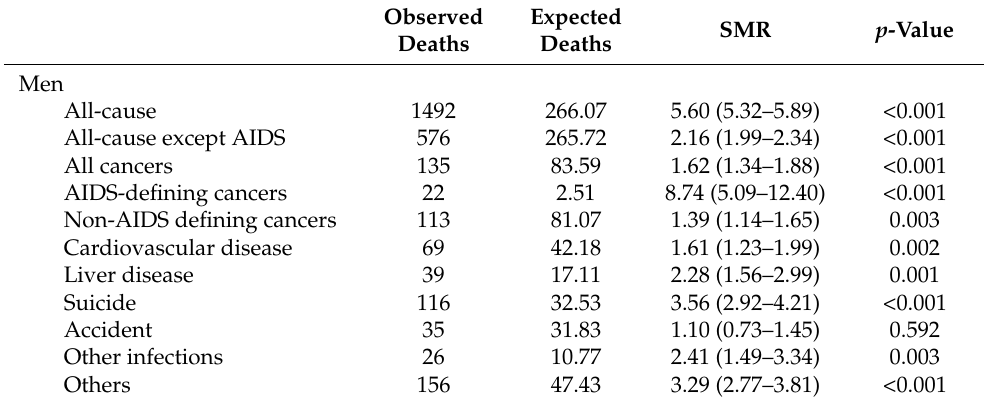
Table 3. Standardized mortality ratios (SMRs) of human immunodeficiency virus (HIV)-infected individuals in Korea according to sex and cause of death, 2004–2018.